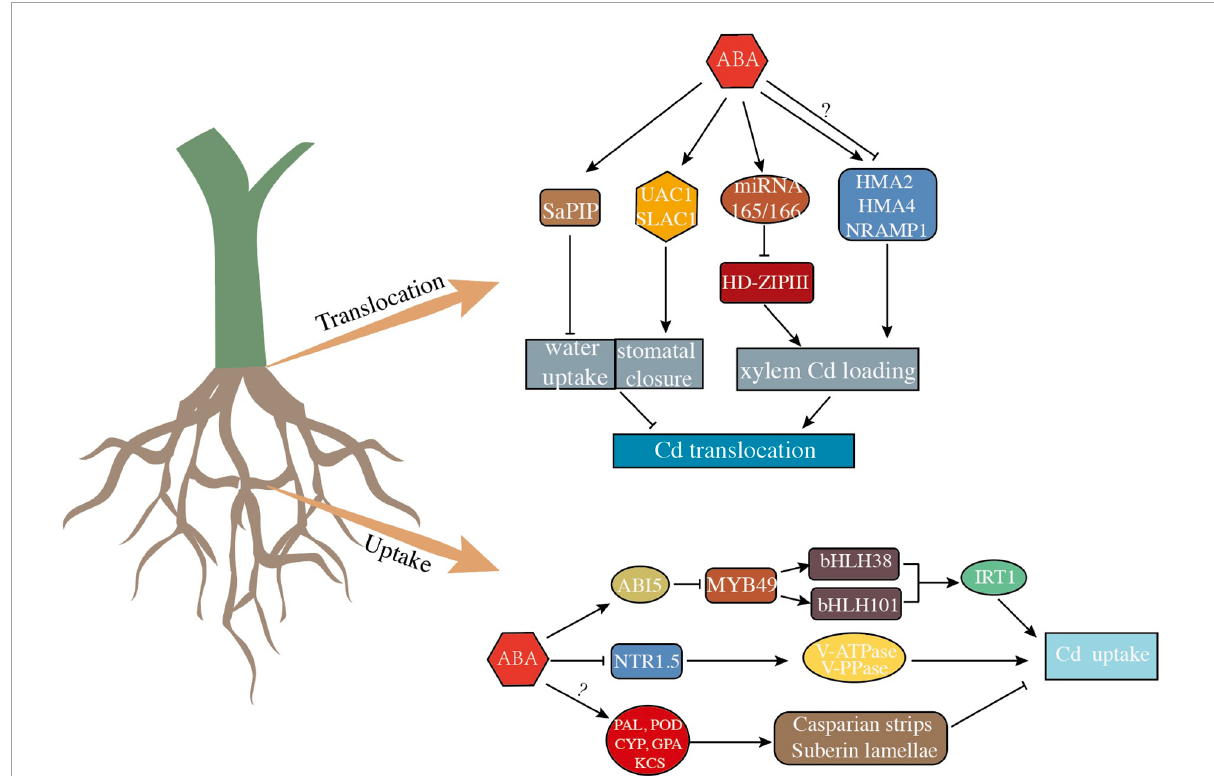
FIGURE2 A proposed model of the effect of abscisic acid (ABA) on Cd uptake and translocation in plants. Arrows indicate positive regulation of ABA and its corresponding targets, bars indicate negative regulation of ABA and its corresponding targets, question marks represent regulatory pathways that remain